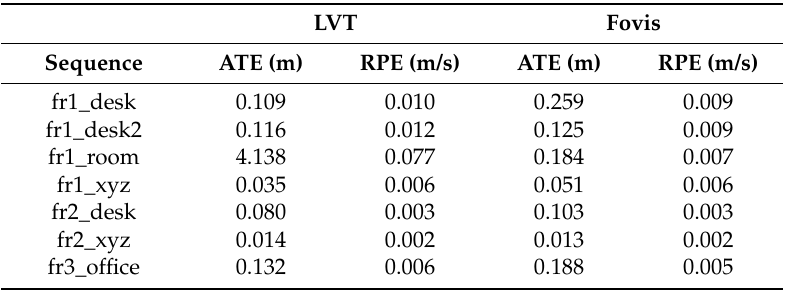
Table 6. RMSE values of ATE and RPE on TUM RGB-D